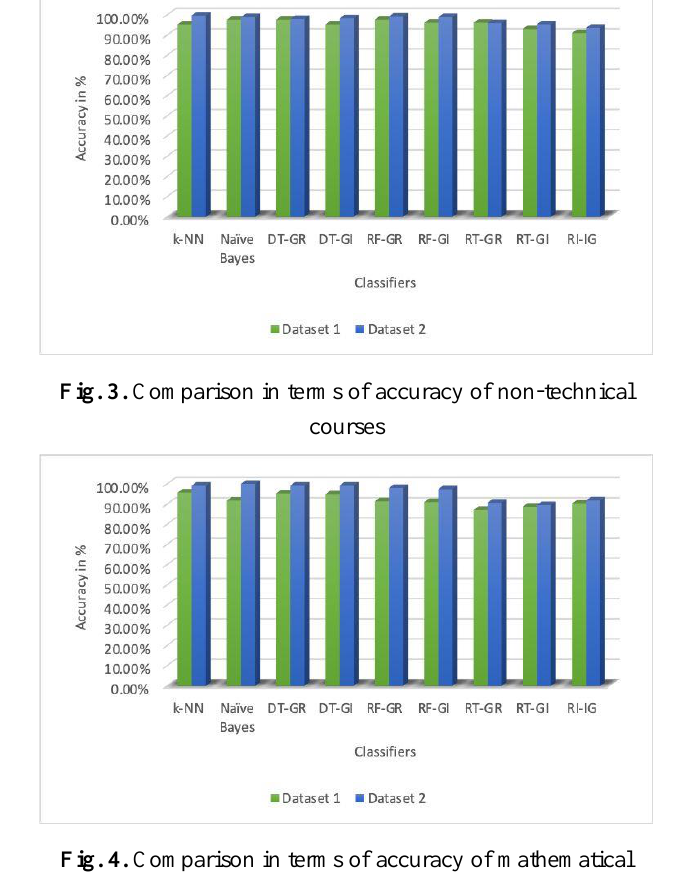
Fig. 4. Comparison in terms of accuracy of mathematical